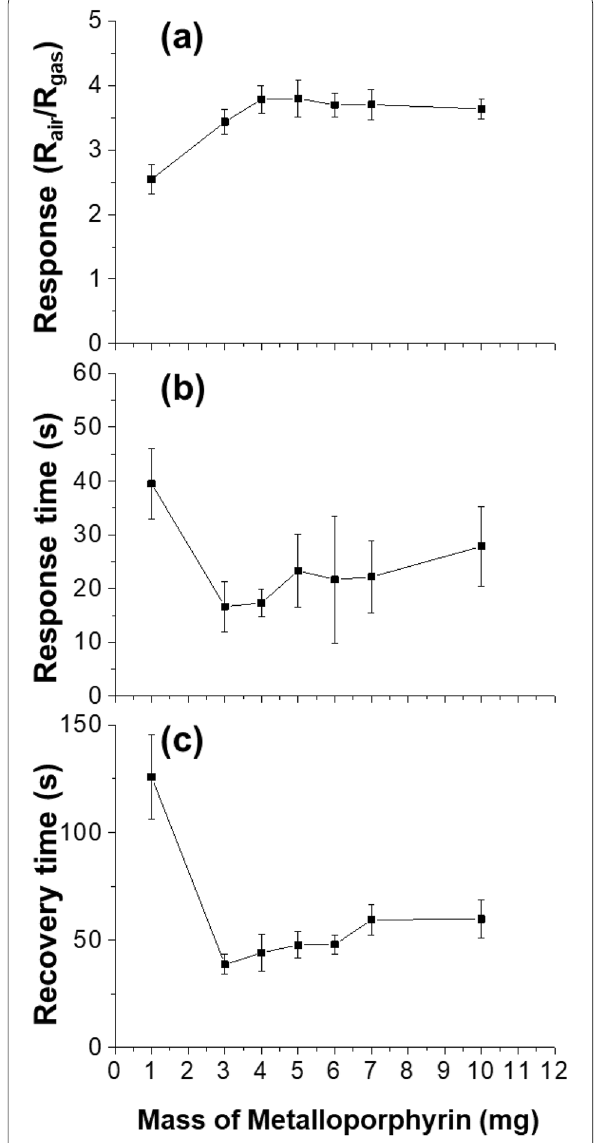
Fig. 5 The response, response time, and recovery time according to the amount of metalloporphyrin deposited on each fabricated sensor. The amount of deposited metalloporphyrin was between 1 and 10